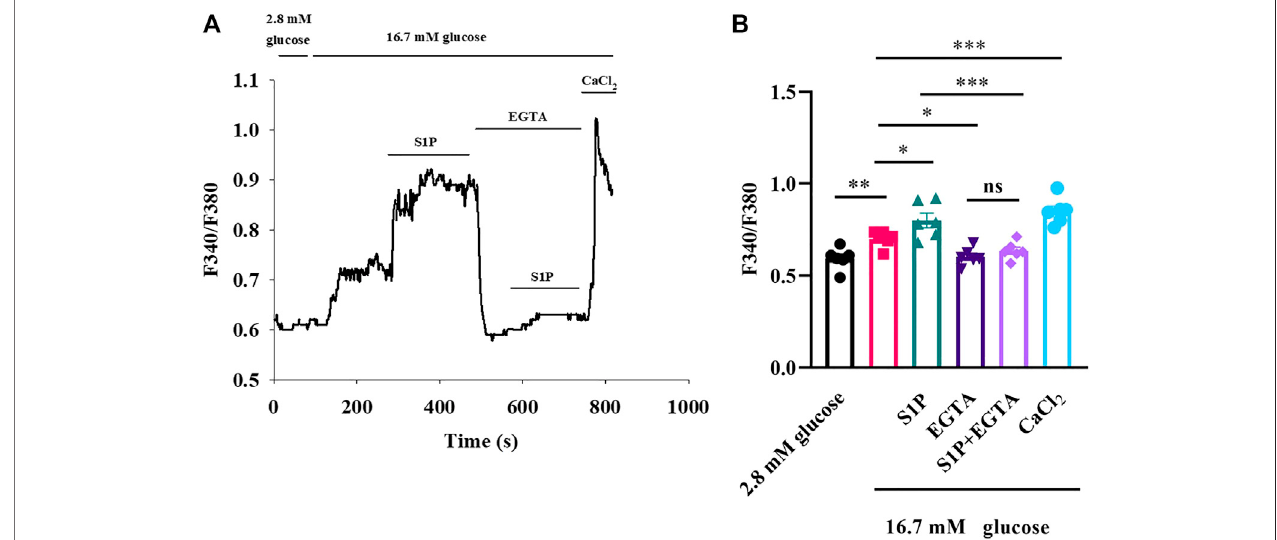
FIGURE 4 | Sphingosine 1-phosphate (S1P) affected [Ca 2+ ] i by promoting Ca 2+ in fl ux rather than releasing intracellular Ca 2+ stores. (A) Changes in F340/F380 values induced by S1P in the presence and absence of EGTA (2.5 mM). EGTA concentrations were suf fi cient to chelate the calcium present in the KRBH buffer (2 mM). Extracellular Ca 2+ using CaCl 2 (5 mM) was added to produce a fi nal concentration of 5 mM of free Ca 2+ at the end of the experiment. (B) Summary of the mean F340/ F380 values with S1P (10 μ M) treatments in the presence or absence of EGTA ( n (cid:2) 6). * p < 0.05, ** p < 0.01, *** p < 0.001; ns, not signi fi cant; by one-way ANOVA. The results represent by the mean ±